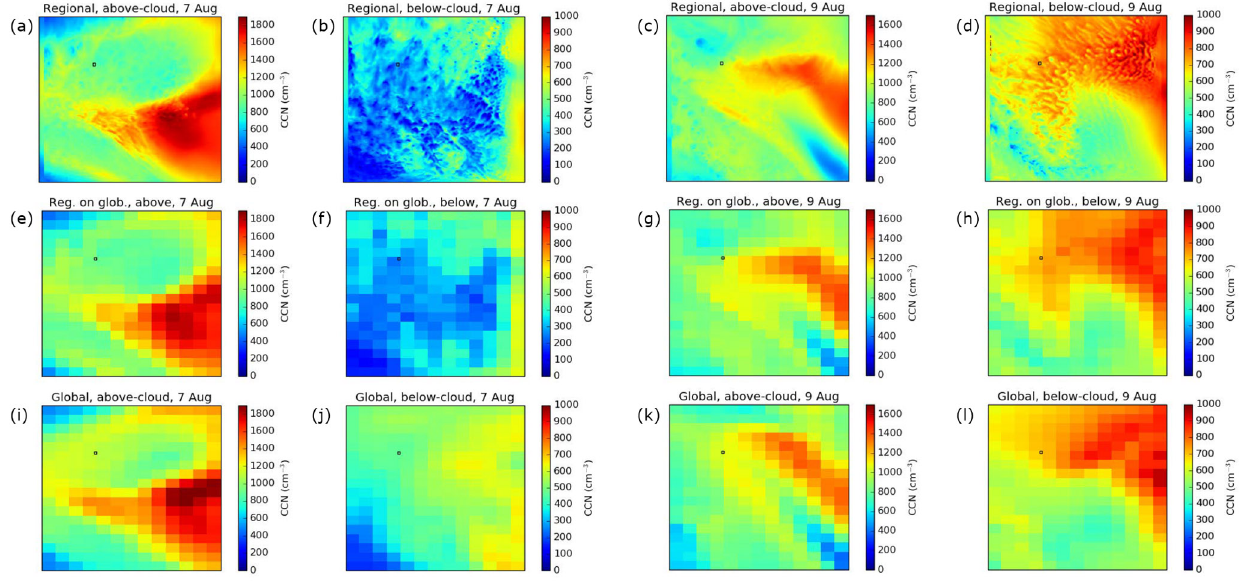
Figure 7. Snapshots of CCN at 0.4% supersaturation across the regional model domain, in the regional and global models. The left six plots show the time of the AQUA overpass on 7 August, also shown for the regional model in Fig. 10. The right six plots show 00:01UTC on 9 August, when the aerosol plume covers different parts of the domain. Within each group, the top plots are for the regional model and the bottom for the global model, left between the domain mean cloud top height and 3500m altitude, and right, below the domain mean cloud top height. Note that clouds extend slightly above the domain mean cloud top height in the western half of the domain. The centre plots are for the regional model, regridded to the same resolution as the global model. The small black square represents Ascension Island.